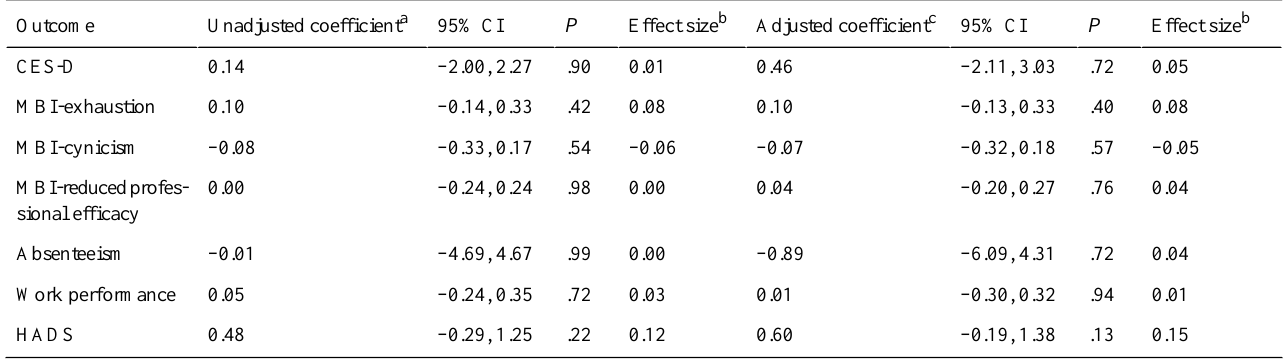
Table 3. Overall effectiveness on different outcome measures.